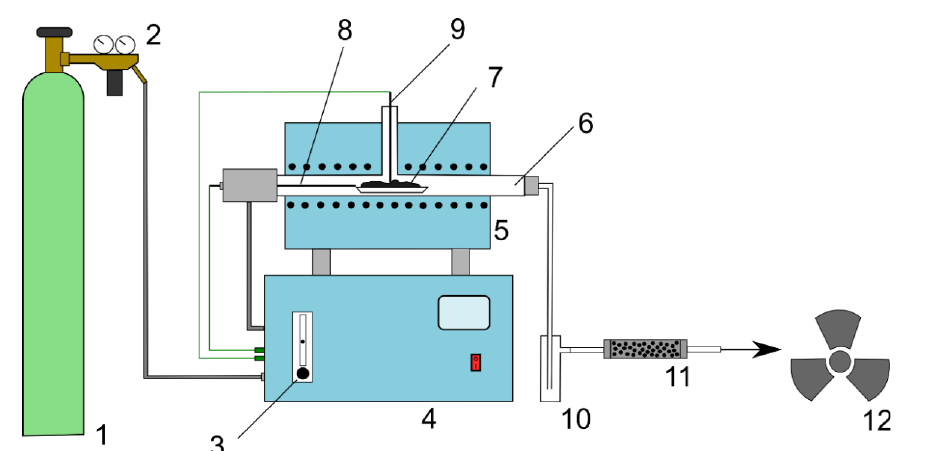
Figure 1. Equipment for the thermal pretreatment of waste: 1—argon cylinder; 2—gas reducer; 3—